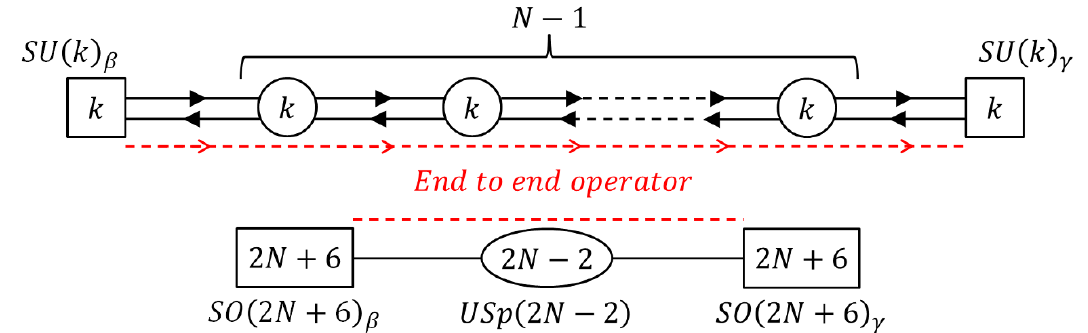
Figure 15 . Quiver diagrams of the tensor branch theories of the 6 d (1 ; 0) T (SU( k ) ; N ) (above) and T (SO(2 N + 6) ; 1) (below) SCFTs. The arrows represent half hyper-multiplets, while lines represent half hyper-multiplets in the ( 2N+6 ; 2N-2 ) representation of SO(2 N +6) (cid:2) USp(2 N (cid:0) 2). The dashed red line represents the \end to end" operators of each